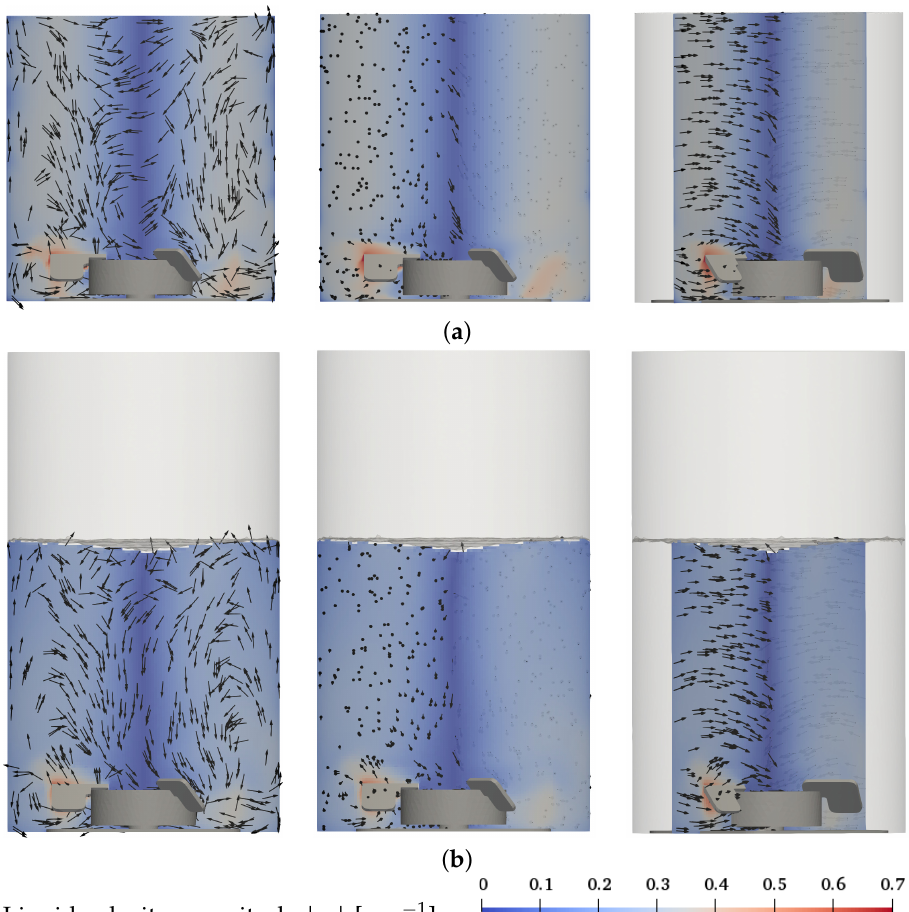
Figure 2. Liquid flow pattern for the base condition 4 (7 L, 100 rpm, 0.25 Lmin − 1 , 2 µ m) in the x - z plane plane through the center of the vessel. Left hand side: front view, arrows show the x - z -velocity direction. Center and right hand side: front and angled views, resp., arrows show the three-dimensional velocity direction. ( a ) Euler–Lagrange results; ( b ) Euler–Euler results.